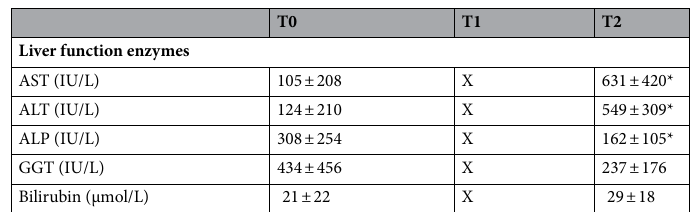
Table 3. Liver function blood results. T0 at the beginning of surgery, T1 at the end of surgery, T2 24 h after surgery, AST aspartate aminotransferase, ALT alanine aminotransferase, ALP alkaline phosphatase test, GGT gamma-glutamyl transferase. Values are represented as mean ± SD, * p < 0.05 compared to T0.